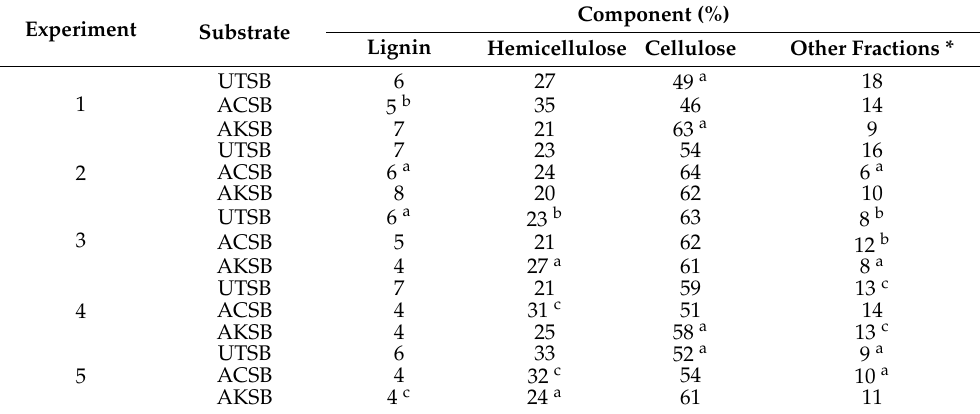
Table 6. Gravimetric analysis of untreated (UTSB), acid pretreated (ACSB), alkali pretreated (AKSB) and fermented Sugarcane bagasse. The details of experiments are given in method